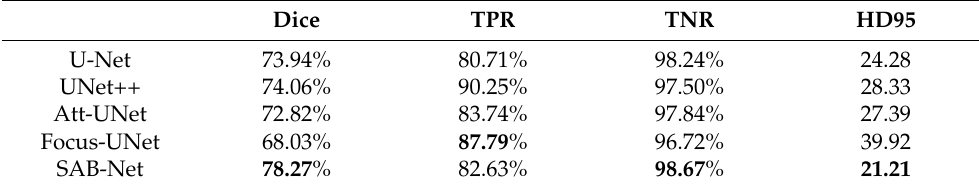
Table 3. Segmentation results obtained on the Liver CT dataset.